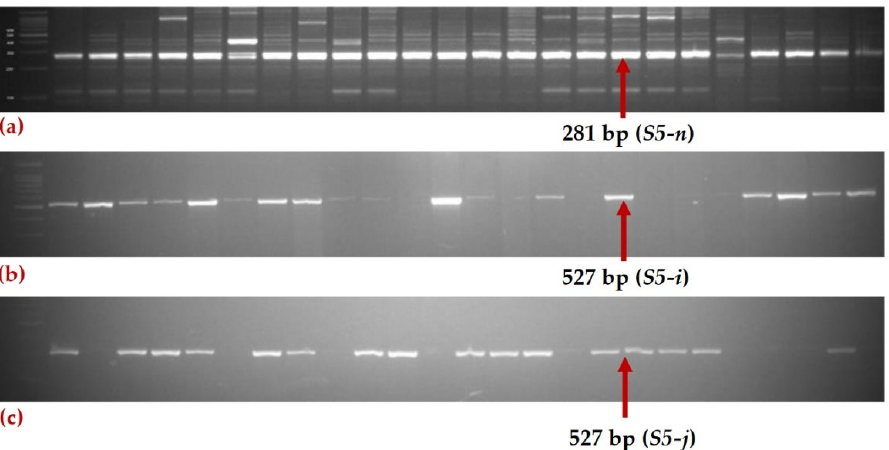
Figure 2. Representative gel images showing the amplification profile of functional markers for different alleles of S5 locus viz., S5-n , S5-i and S5-j in the 967 lines. ( a ) Screening for S5-n allele using S5-InDel primer; ( b ) screening for S5-i allele using S5-ELSP; ( c ) screening for S5-j allele using